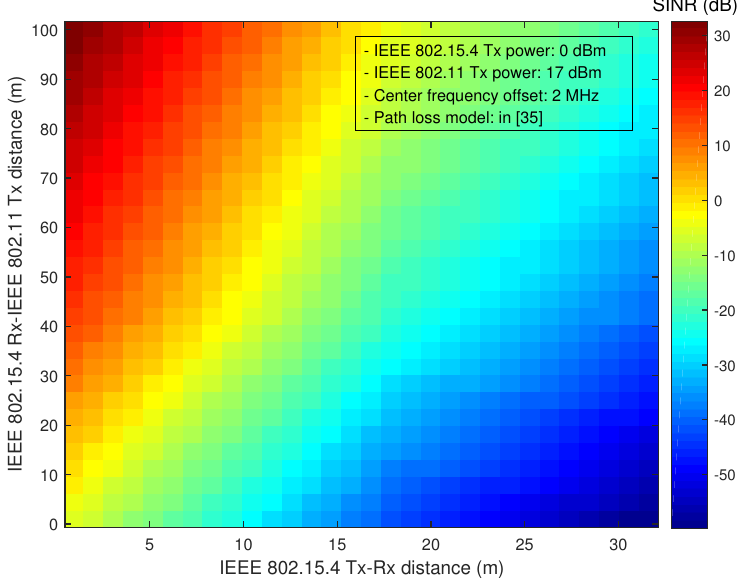
Figure 1. signal-to-interference-plus-noise ratio (SINR) of IEEE 802.15.4 in the presence of co-channel